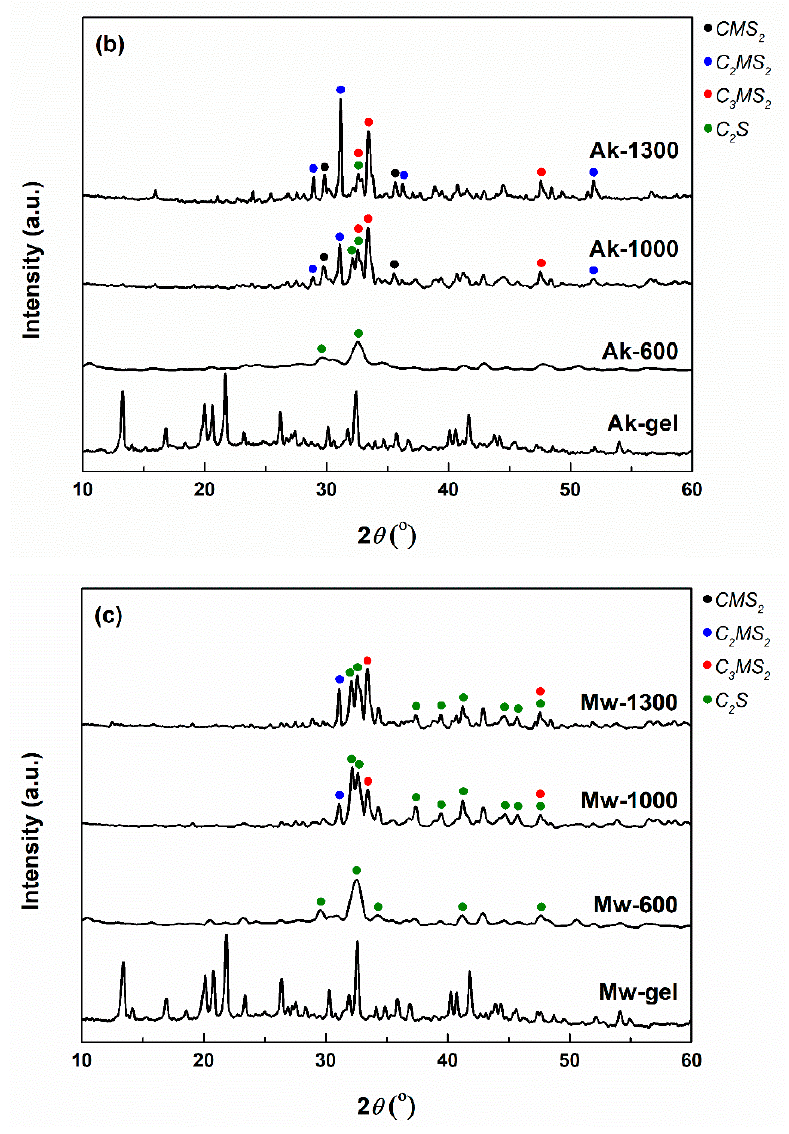
Figure 8. XRD patterns spectra of the dry gels and ceramics corresponding to: ( a ) diopside; ( b ) akermanite; and ( c ) merwinite compositions.